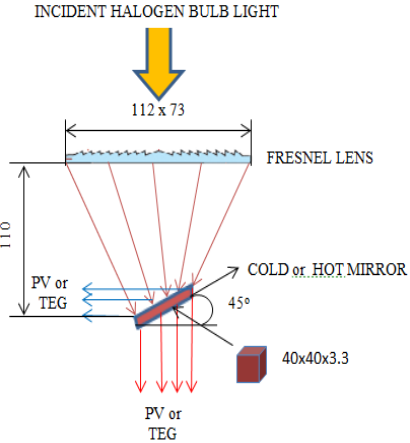
Figure 1. The schematic of a potential photovoltaic-thermoelectric generator (PV-TEG) hybrid.